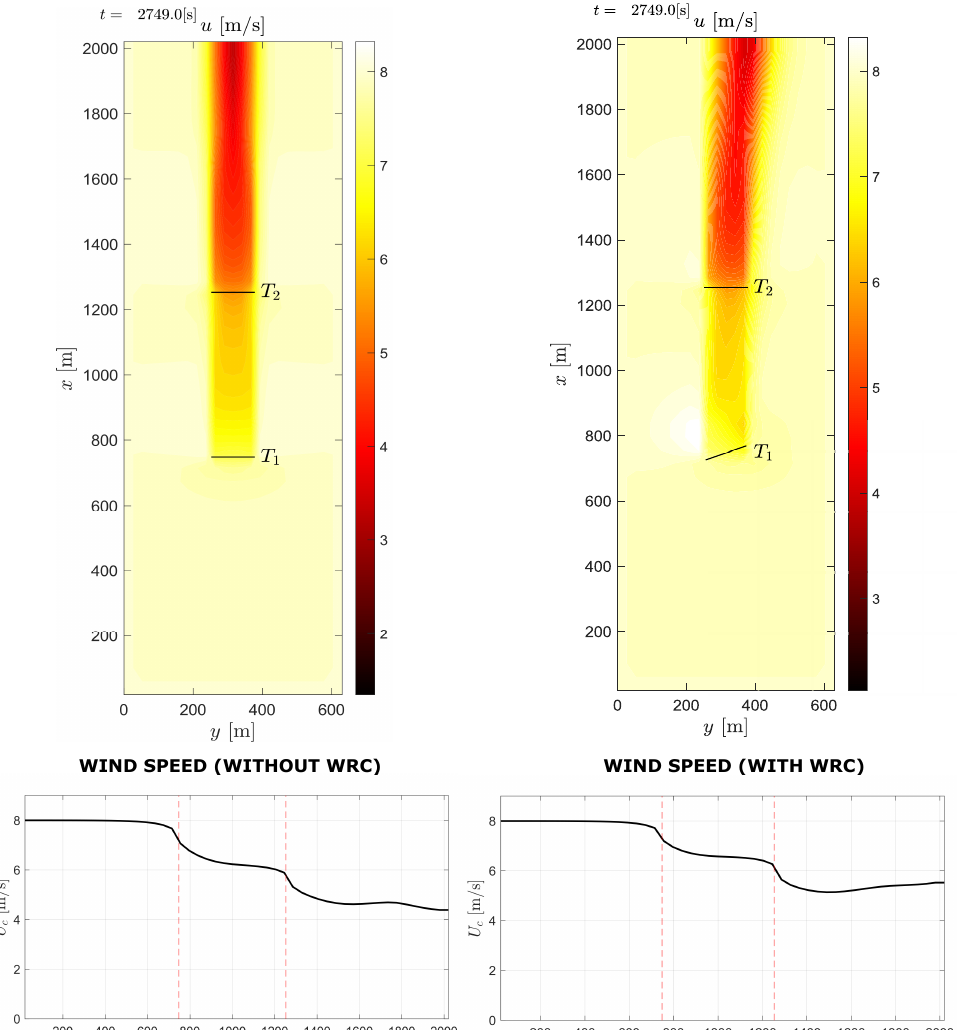
Figure 12. Two-turbine case with and without WRC for 4D